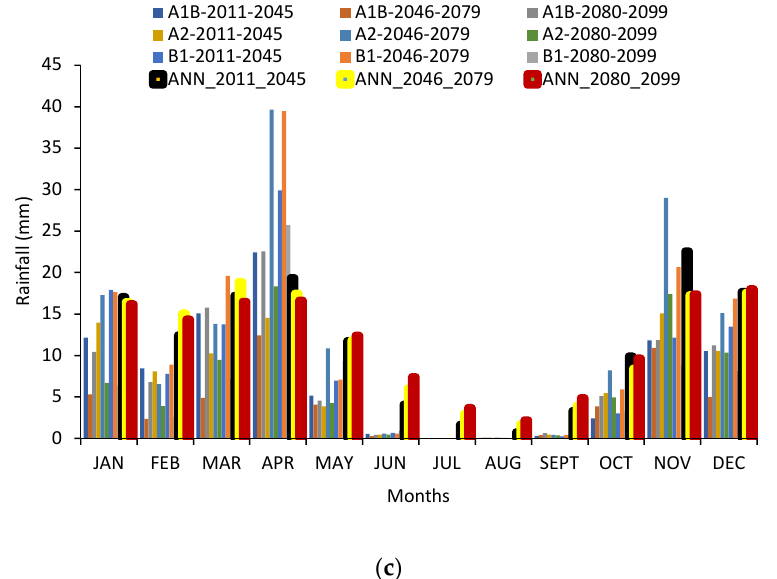
Figure 13. Rainfall predicted under three emissions scenarios using the ANN and various GCMs: ( a ) rainfall predicted under three emissions scenarios using the ANN and GCM-HADCM3; ( b ) rainfall predicted under three emissions scenarios using the ANN and GCM-INCM3; and ( c ) rainfall predicted under three emissions scenarios using the ANN and GCM-MPEH5.